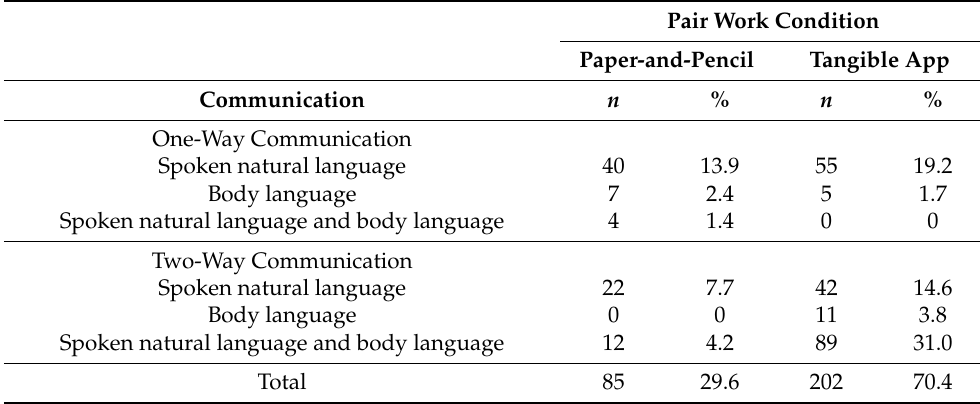
Table 2. Frequencies and percentages of on-task peer communication episodes ( N = 287) regarding directions and modalities by pair work condition.